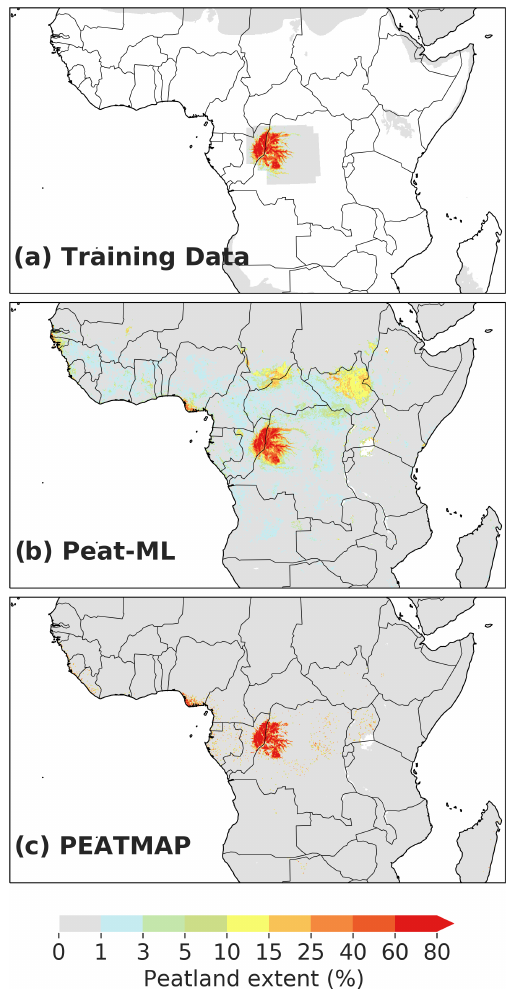
Figure 8. Peatland extent over central Africa. Panel (a) shows the ML training data, panel (b) shows the Peat-ML-predicted peatland extent, and panel (c) shows the PEATMAP extent from Xu et al.